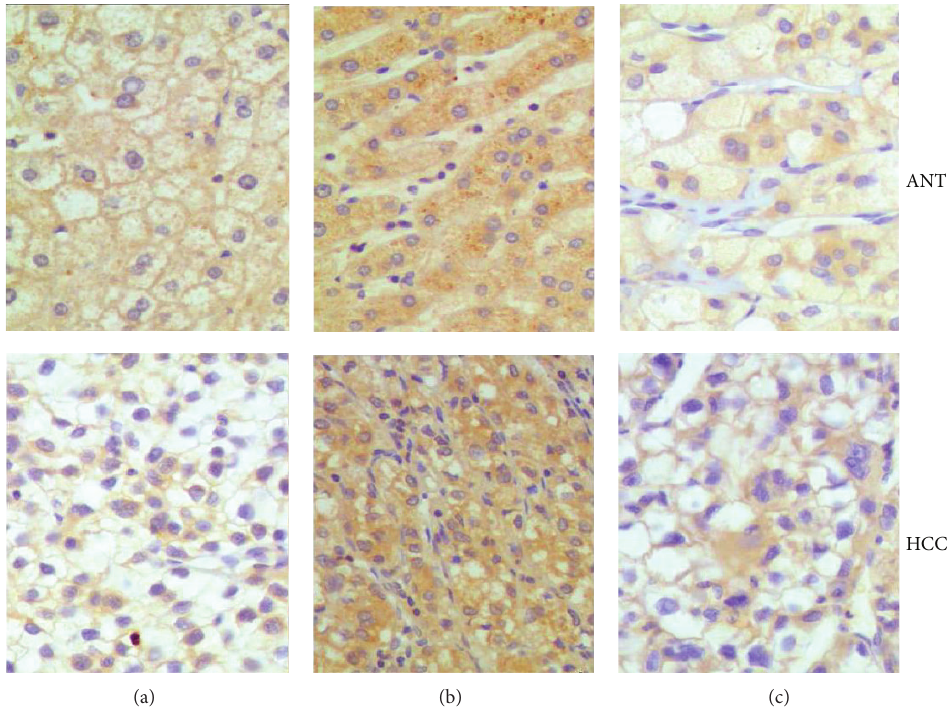
Figure 1: TLR3 expression and location in HCC and ANT tissues. TLR3 exhibited cytoplasm (a), cytomembrane staining (b), and cytoplasm/cytomembrane (c), respectively, in HCC and ANT. (IHC magnification ×